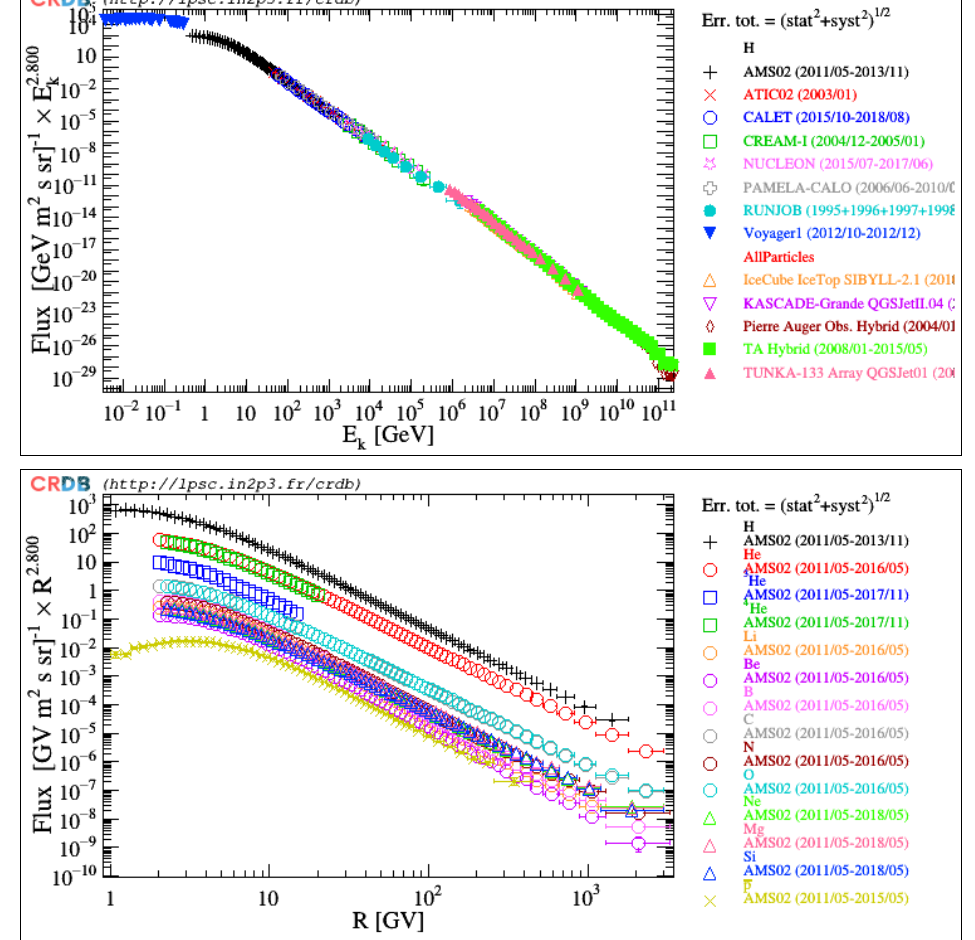
Figure 7. Illustration of the new multi-quantity plotting capability in CRDB v4.0 : ( Top panel ): H flux from IS MeV data (Voyager1 [113]) up to PeV data (AMS02 [13], ATIC02 [114], CALET [115], CREAM-I [116], NUCLEON [117], RUNJOB [118], PAMELA-CALO [119]); and AllParticle flux from PeV to EeV energies (KASCADE-Grande [120], IceCube IceTop [108], and Pierre Auger Observatory [121]), Telescope Array [122], and TUNKA-133 Array [110]). ( Bottom panel ): Nuclear component measured to date by AMS-02